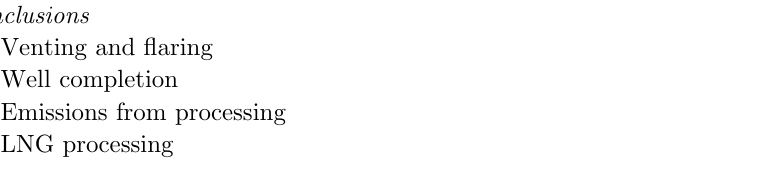
Table 1. Emission source